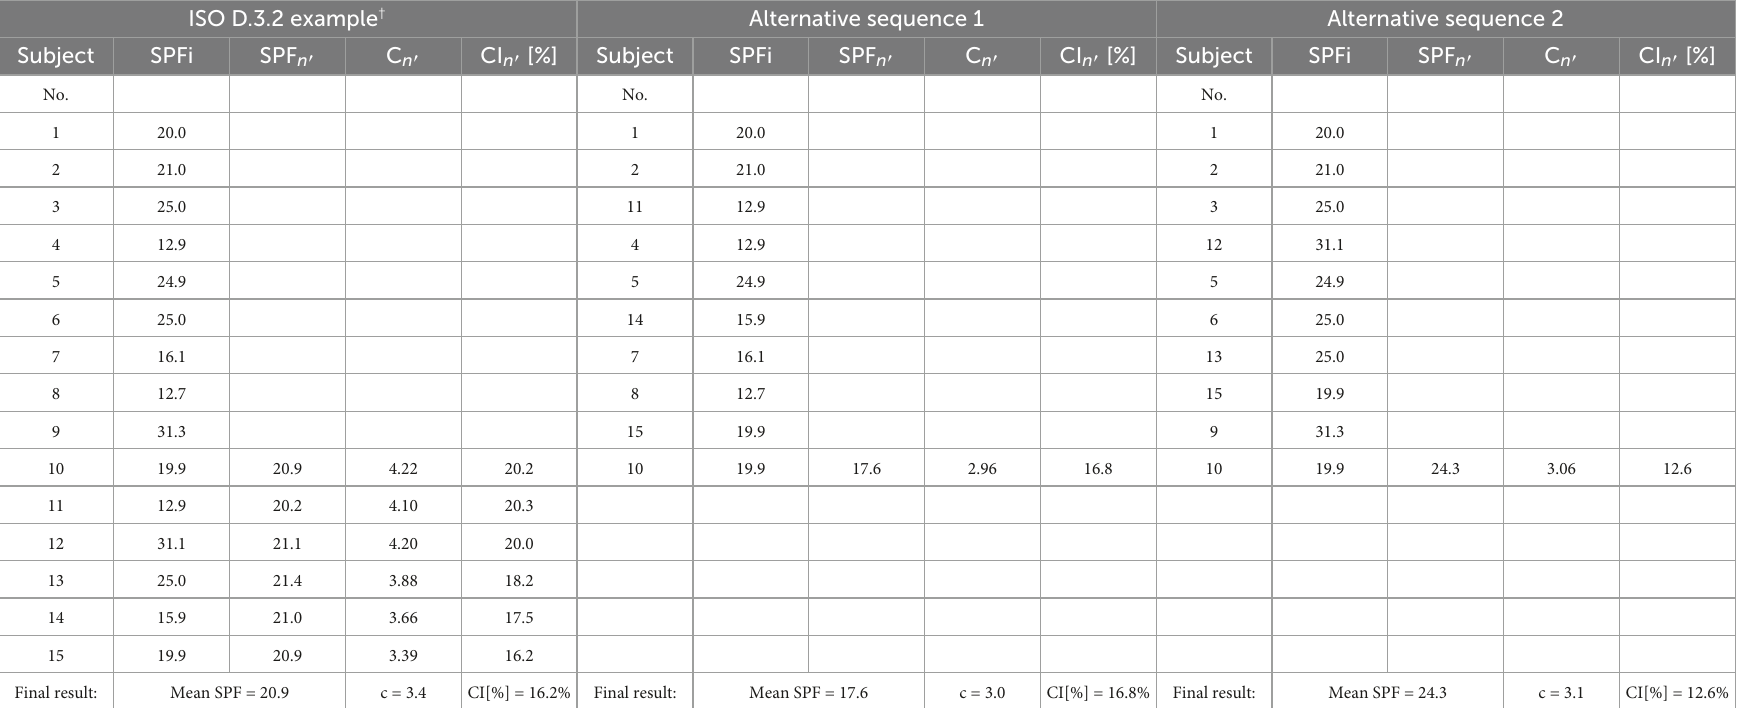
TABLE 2 Sun protection factor results with illustrative